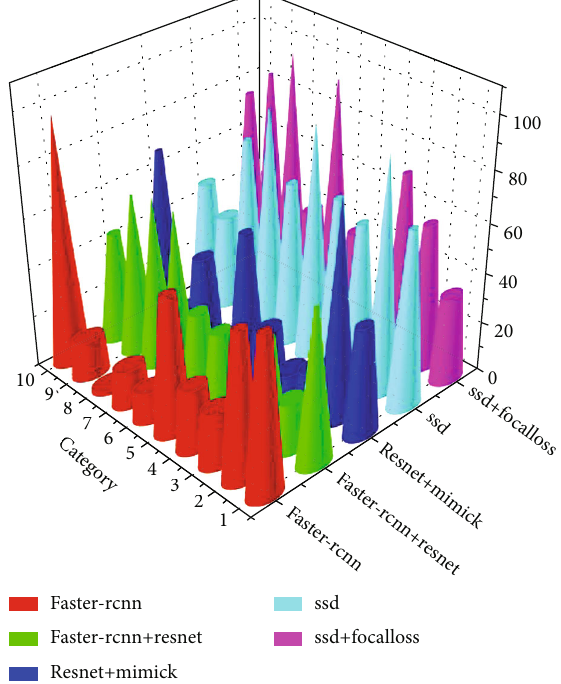
Figure 5: Comparison of accuracy test results of di ff erent human fi gure detection